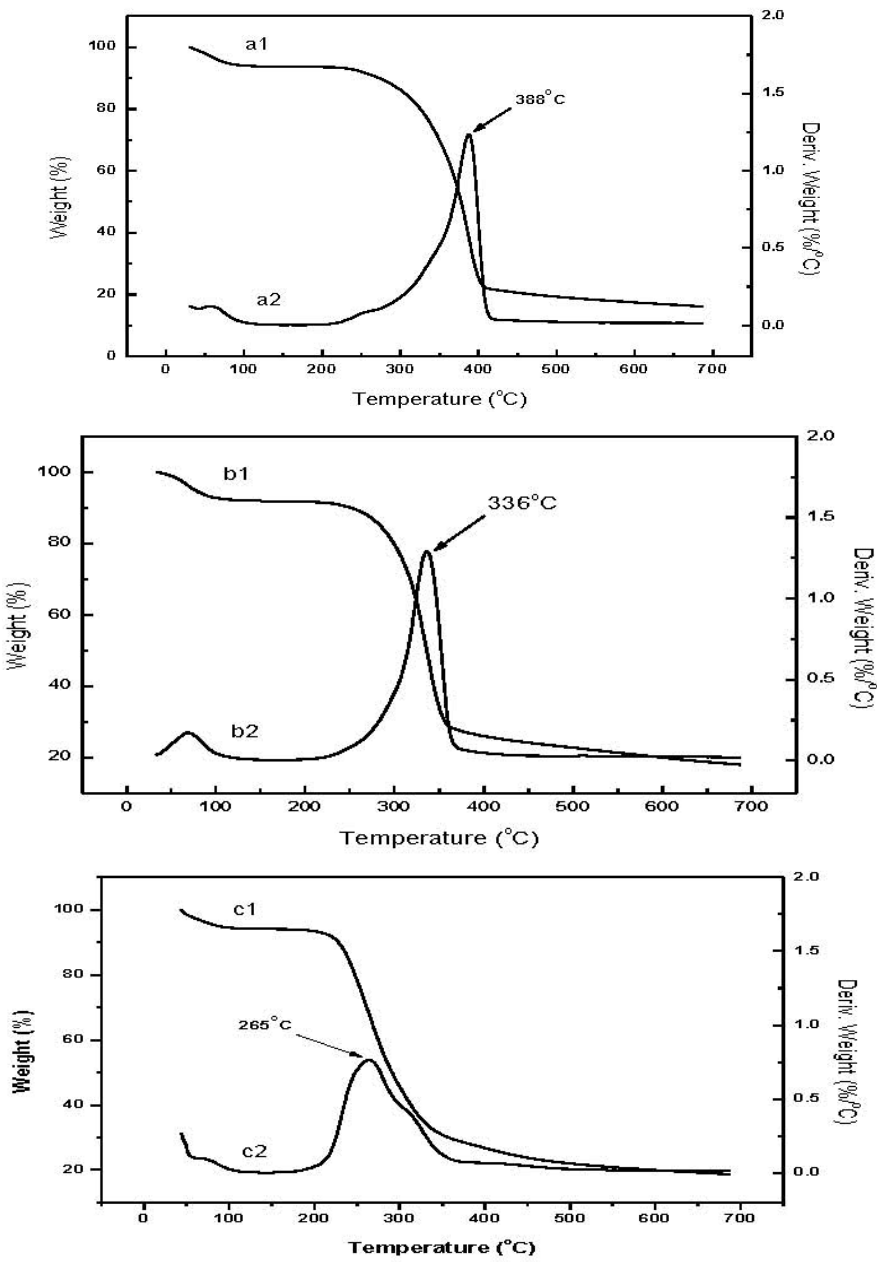
Figure 5. Thermograms of raw chitin, low molecular weight chitin and CM: a1, b1, c1, correspond to the weight loss curve; a2, b2, c2, correspond to the derivative weight loss